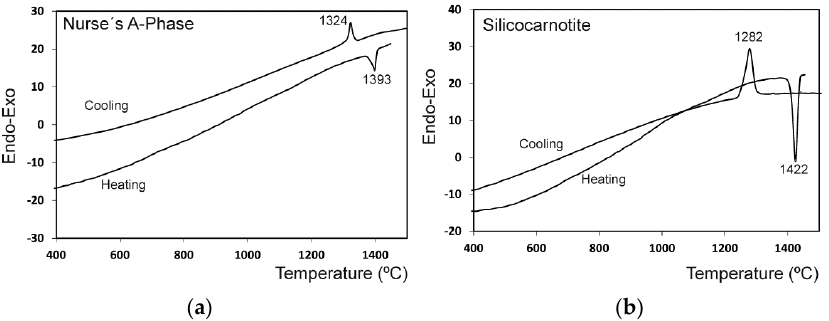
Figure 2. DTA of the Nurse’s A-phase ( a ) and silicocarnotite materials ( b ). The experimental results showing the phase coexisting in equilibrium for each composition after the solid state treatment at the selected temperatures and plateau times are summarized in Table 2. Table 2. Phases identified by XRD for each composition after the heat treatment at the selected temperatures and plateau times. (S ss : silicocarnotite ss ; A ss : Nurse´s A-phase ss ; R ss : ( α -C 2 S- α ´TCP) ss ; * Fix et al . invariant point.)